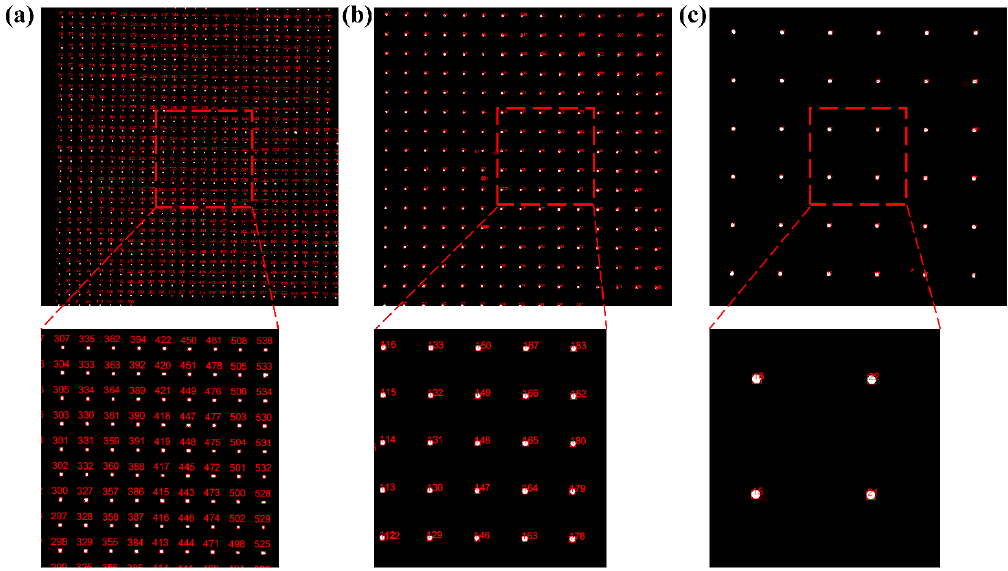
Figure 3. Experimental results of the standard particle glass plate at the distance of 6 mm from the focal plane. ( a ) 2 μm particles. ( b ) 10 μm particles. ( c ) 20 μm particles. In order to promote the application of in-line DHI in meteorological detection and atmospheric cloud microphysics research, it is necessary to carry out various comparison experiments with recognized cloud droplet detection instruments. The fog monitor [53 – 60] is widely used in mountain stations and cloud chambers to observe the cloud and fog